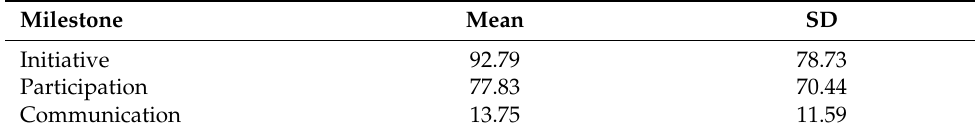
Table 5. Mean online data per student (Experimental Group).